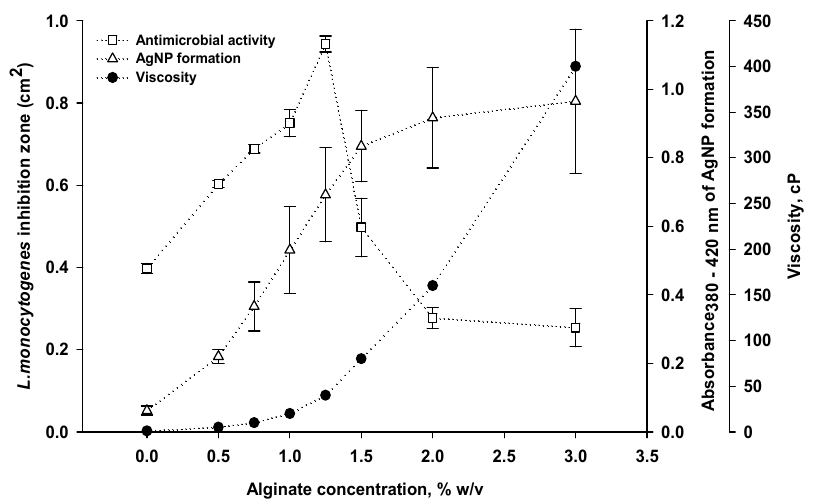
Figure 3. Effect of alginate concentration on antimicrobial activity, viscosity and AgNPs formation of alginate–silver coating.